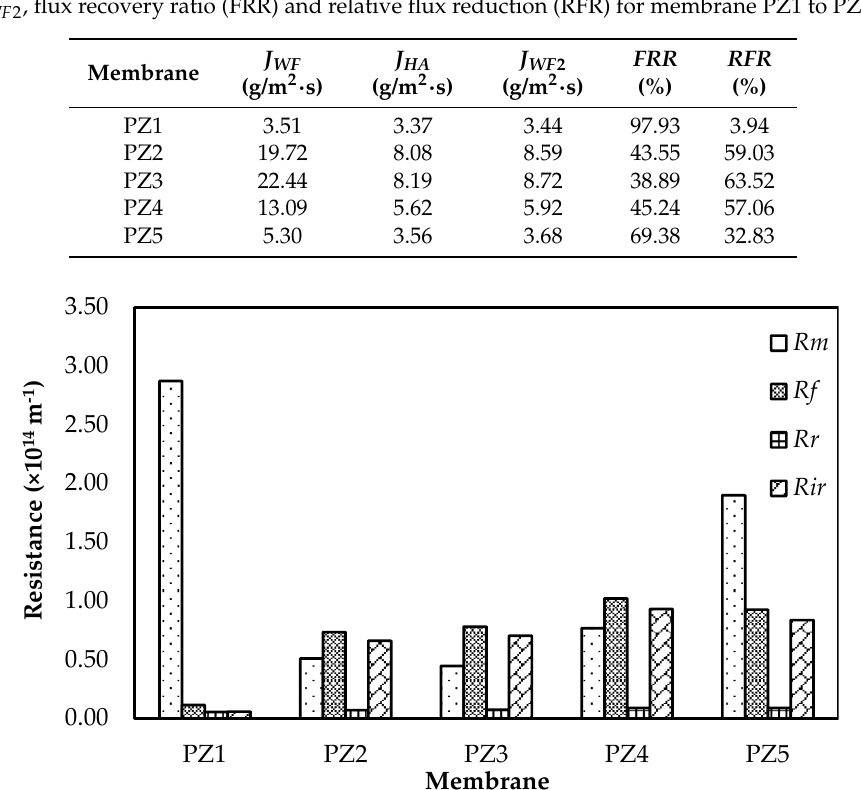
Table 4. The numerical analysis of initial water flux J WF , humic acid (HA) filtration J HA , second water